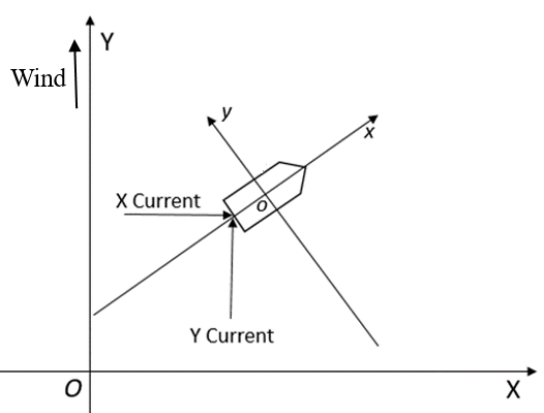
Figure 6. Schematic diagram of ship motion under the influence of wind and